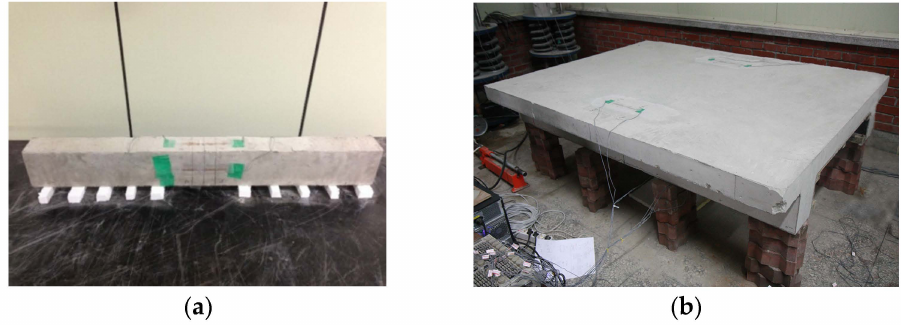
Figure 3. Specimen setups: ( a ) Rectangular beam ( b ) Double-T beam.